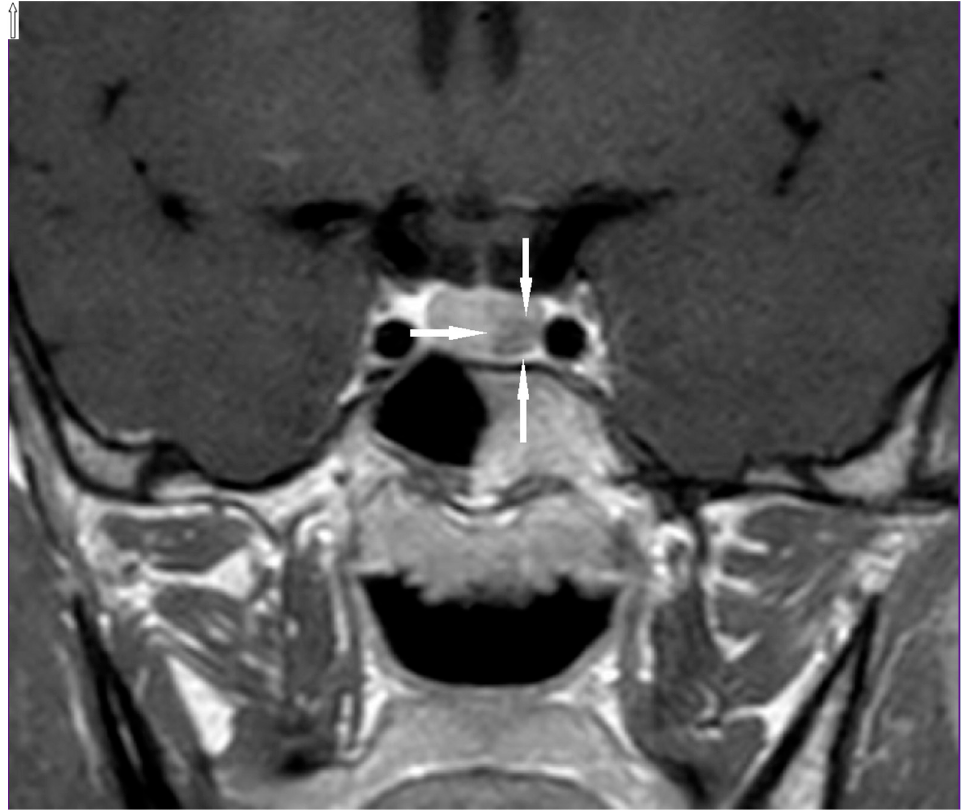
Figure 2. Pituitary microadenoma (arrows) visible in the MRI of the proband.